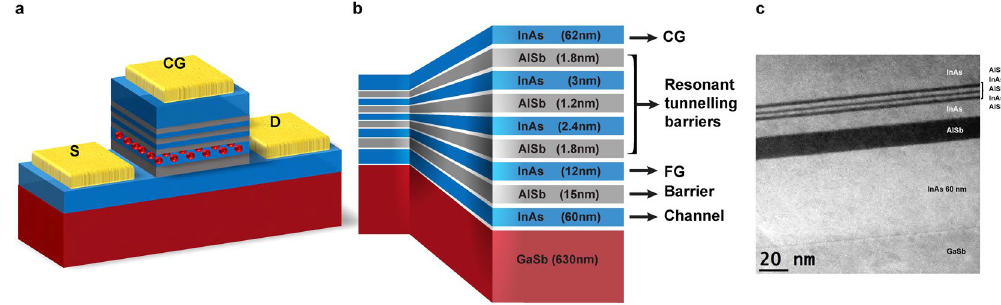
Figure 1. Device structure. ( a ) Schematic of the processed device with control gate (CG), source (S) and drain (D) contacts (gold). The red spheres represent stored charge in the floating gate (FG). ( b ) Details of the layer structure within the device. In both ( a , b ) InAs is coloured blue, AlSb grey and GaSb dark red. ( c ) Cross- sectional scanning transmission electron microscopy image showing the high quality of the epitaxial material, the individual layers and their